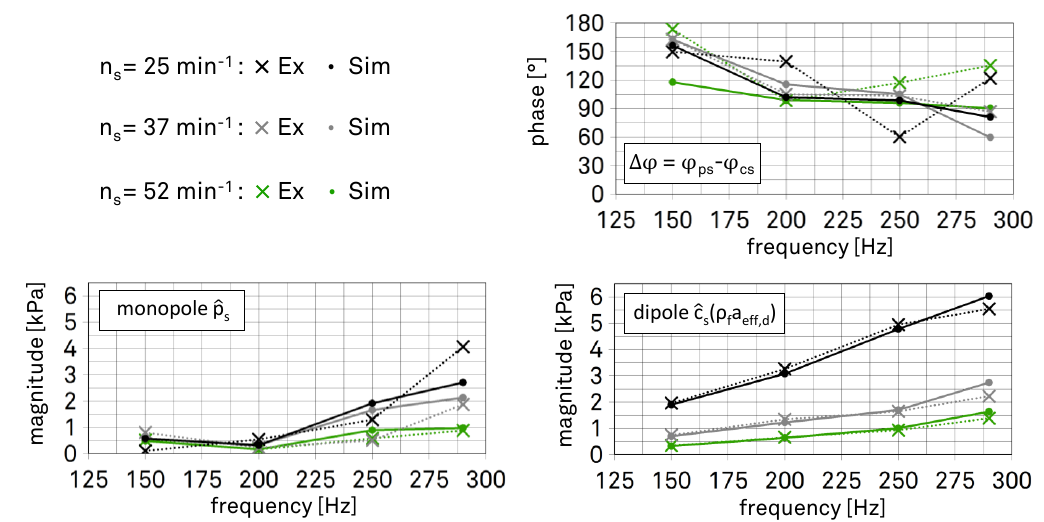
Figure 8. Experimental determined magnitudes and phase differences of monopole p s and dipole c s ( ρ f a ef f , d ) source as a function of frequency using the experimental (Ex) or numerical (Sim) obtained transmission parameters for nominal operation